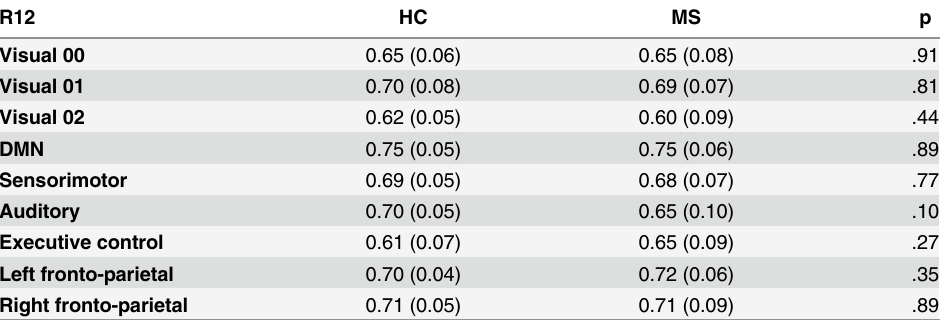
Table 4. Mean overlap (R12) of individual Z-thresholded connectivity maps (Z > 0) for each network for HC and MS.